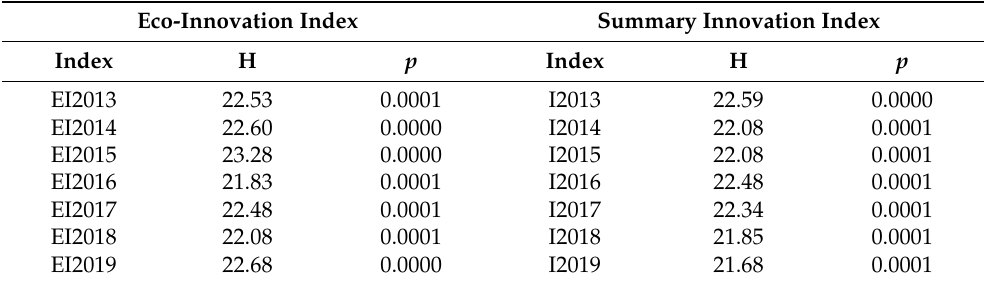
Table 4. Kruskal–Wallis test statistics for four classes of the European Union countries identified using the k-means method regarding the values of the Eco-Innovation Index and Summary Innovation Index in 2013–2019.